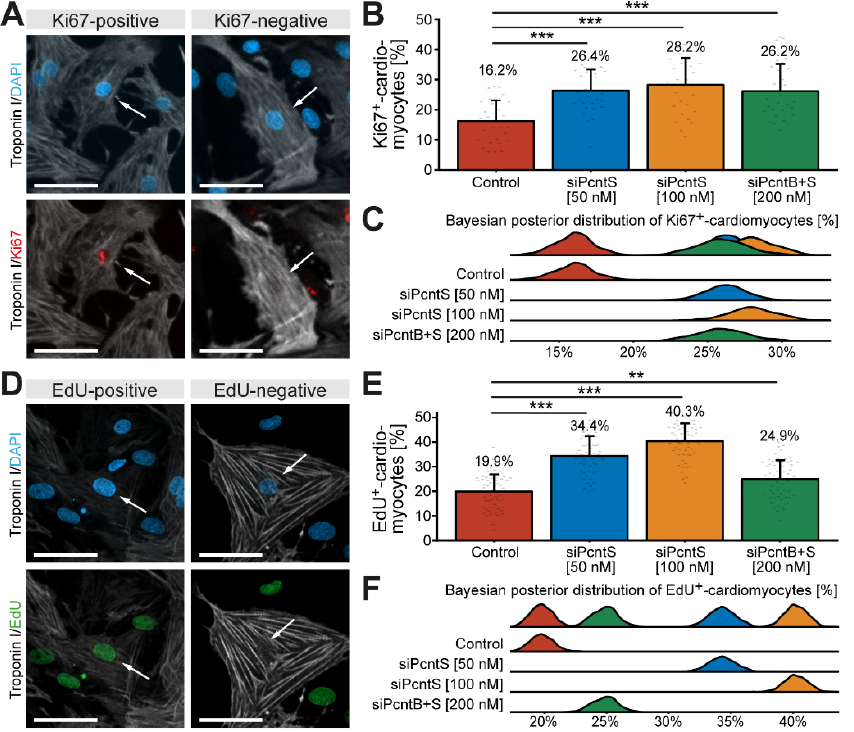
Figure 6. Depletion of Pcnt S increases cell-cycle activity and DNA synthesis in postnatal cardiomyocytes. ( A , D ) Representative examples of P3 cardiomyocytes (troponin I) stained for Ki67 ( A ) and incorporated EdU ( D ). Nuclei were visualized with DAPI (DNA). ( B , E ) Quantitative analysis of Ki67 + ( B ) and EdU + ( E ) cardiomyocytes upon control (mock-transfected) and Pcnt isoform depletion as indicated. ( C , F ) Bayesian posterior distribution for the data in ( B , E ). Scale bars: 50 µm. White arrows: cardiomyocyte nuclei. Data are mean ± SD, **: p < 0.01, ***: p < 0.001. For the experiments, ≥ 15,000 cardiomyocytes were analyzed per experimental condition.